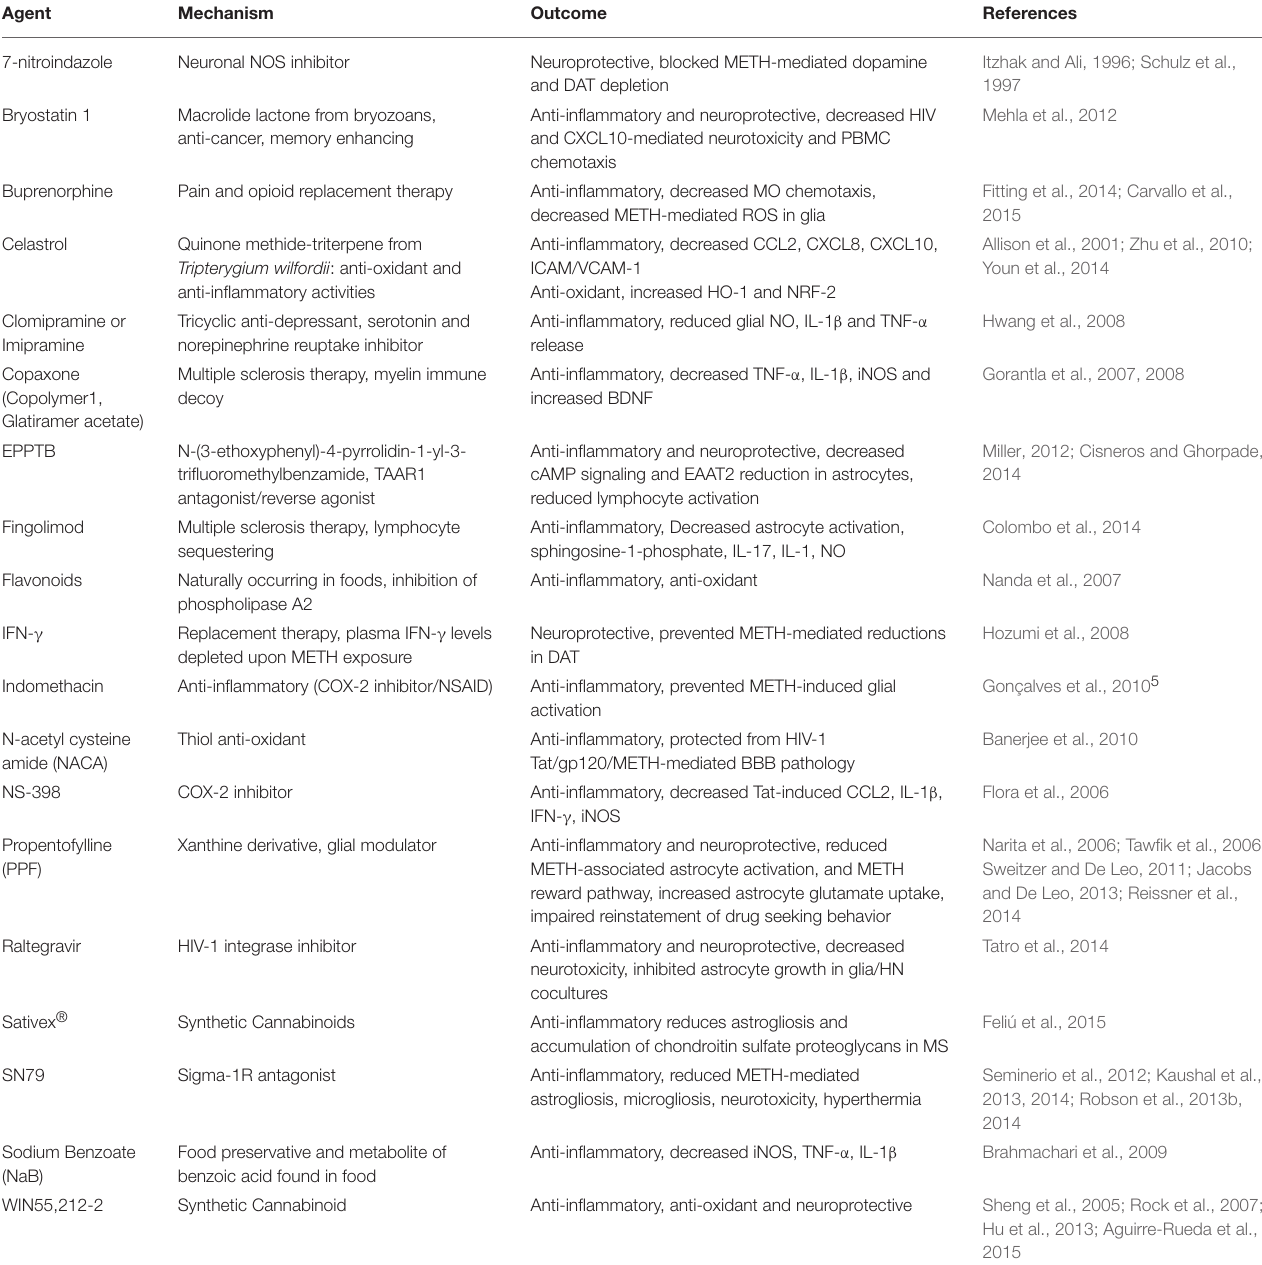
TABLE 3 | Therapies targeting astroglial activation and